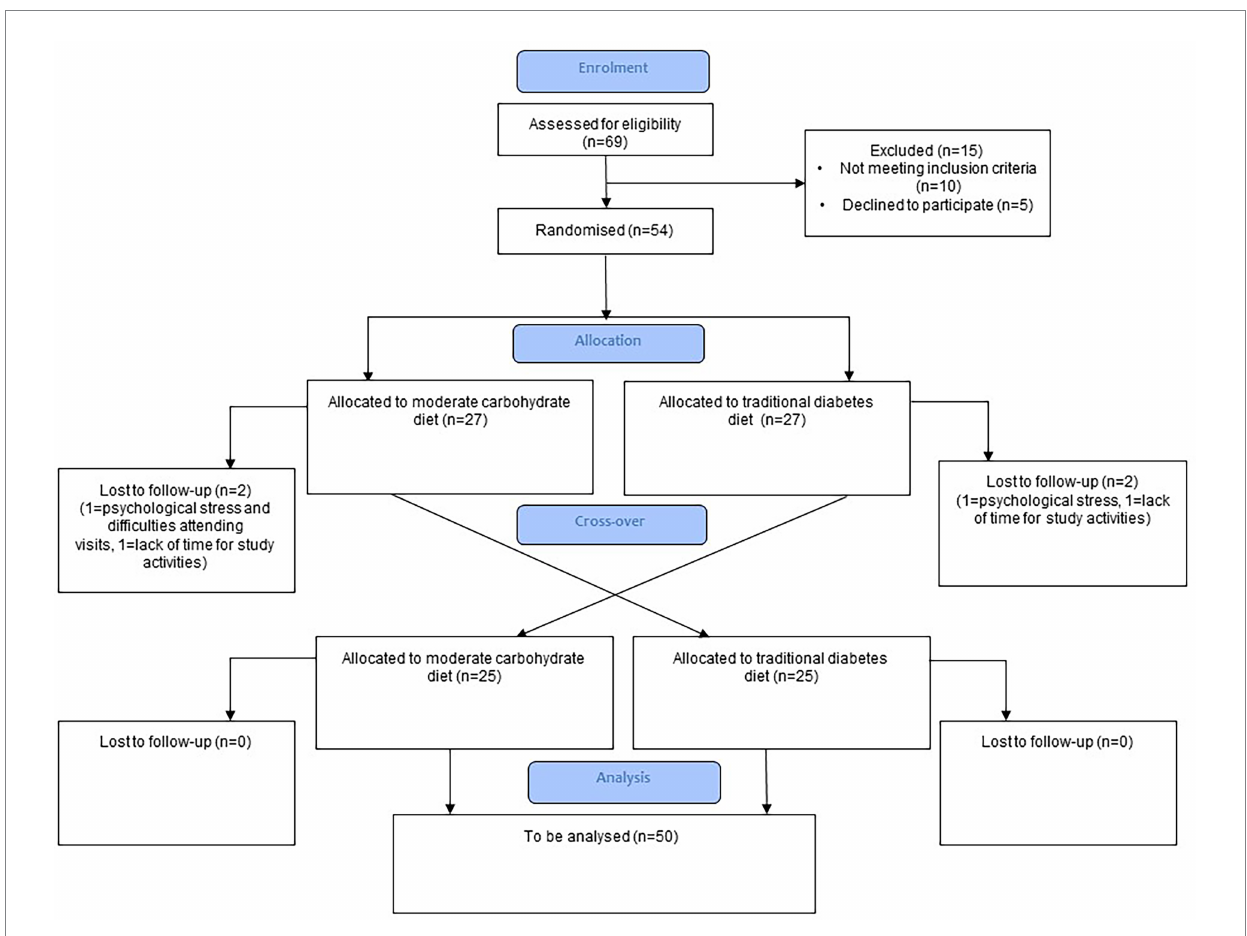
FIGURE 1 Flow diagram of participants during the cross-over study according to CONSORT.